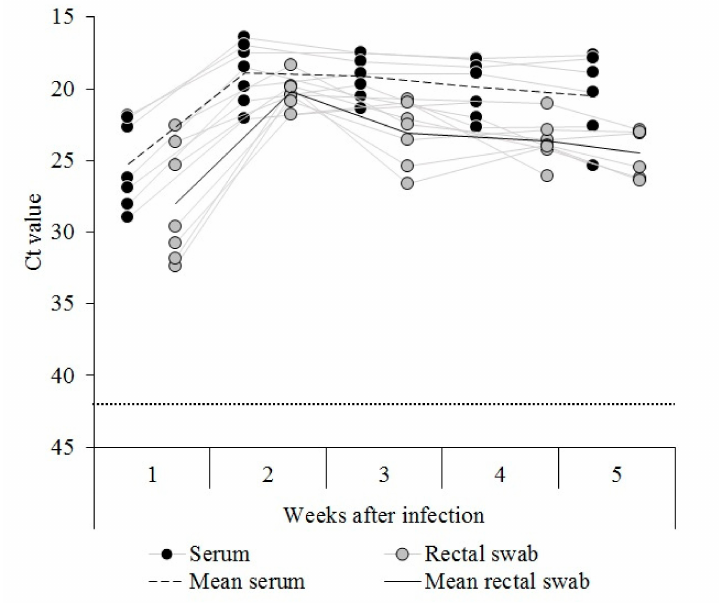
Figure 2. RNA detection in the sera and rectal swabs from the Cat01 infected pigs. Classical swine fever virus (CSFV) RNA was evaluated weekly in the sera (black dots) and rectal swab (gray dots) samples for 5 weeks after infection. Ct values above 42 (dotted line) were considered negative. Mean values for the serum and rectal swab samples are also